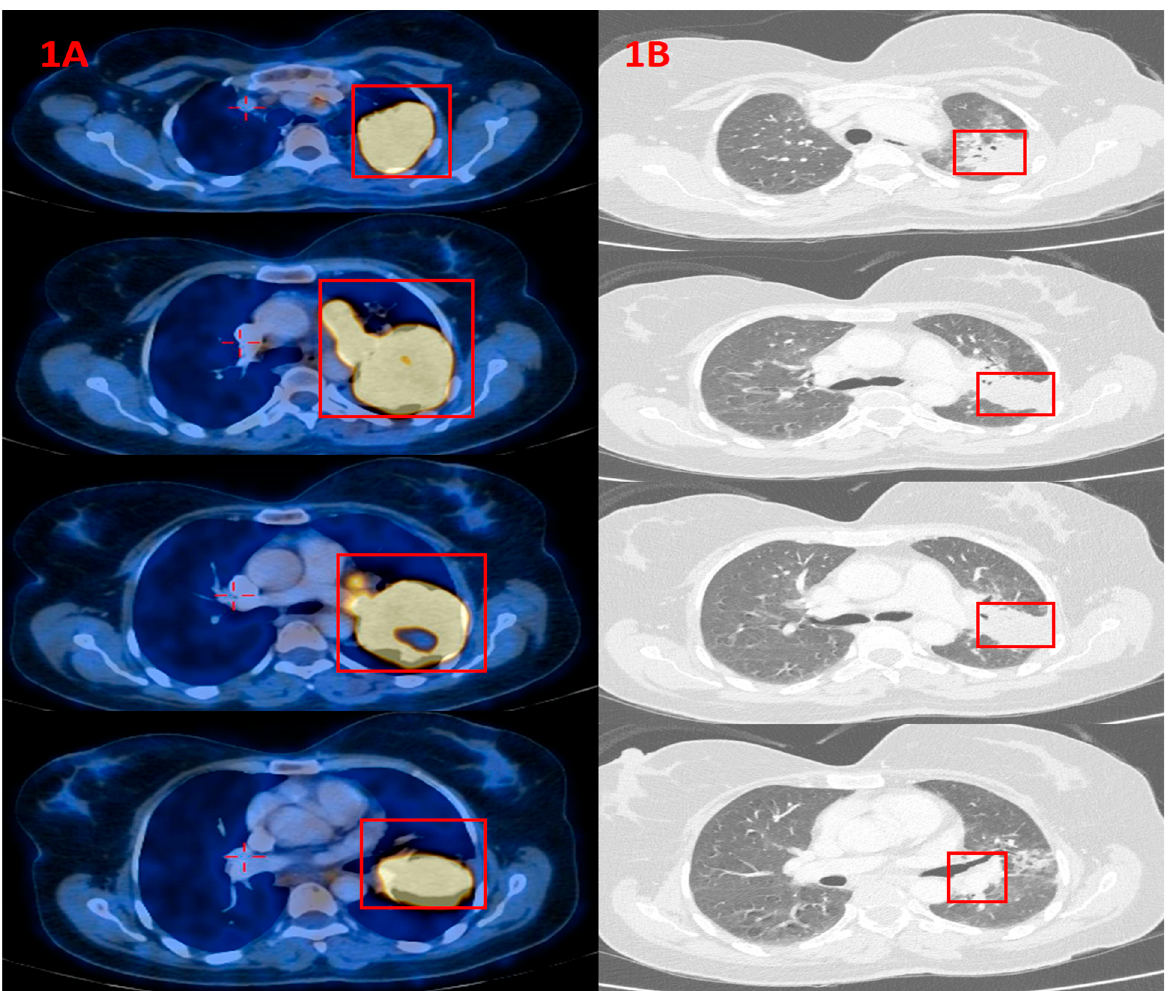
Figure 1. ( A ) PET-CT (29 April 2021) with hypermetabolic uptake of the tumor in the left lung (red squares), before starting alectinib. ( B ). CT scan of chest (12 July 2021) showing radiological significant improvement, with the left lung mass having decreased in diameter (red squares) after starting alectinib, along with elevation and subsequent normalization of ALP values.